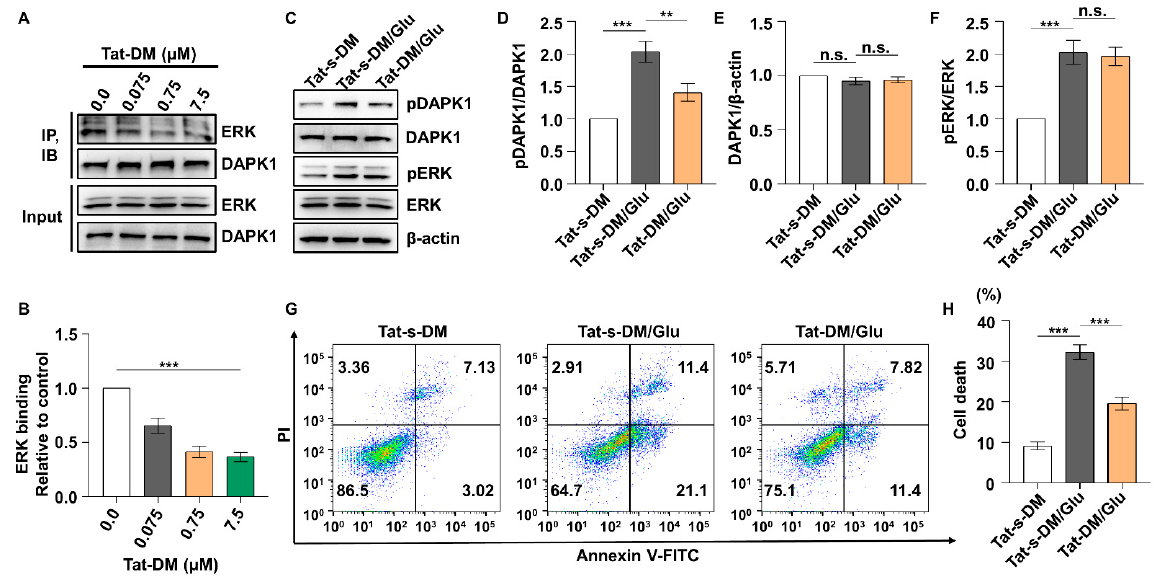
Figure 7. Uncoupling DAPK1 from ERK reverses neuronal apoptosis induced by glutamate. HT22 cells were incubated with 0, 0.075, 0.75, and 7.5 µ M Tat-DM for 180 min. ( A , B ) HT22 cell lysates were immunoprecipitated with DAPK1 antibody, resolved on SDS-PAGE gels and subjected to immunoblotting assays using anti-DAPK1 or anti-ERK antibodies (*** p < 0.001; one-way ANOVA with Tukey’s multiple comparisons test). HT22 cells were pretreated with 7.5 µ M Tat-DM for 180 min followed by washing with PBS. Cells were harvested 1 h after 10 mM glutamate incubation and used in immunoblotting assays with anti-pSer735-DAPK1, anti-DAPK1, anti-pThr202/Tyr204 ERK, anti-ERK, or anti- β -actin antibodies ( C – F ), and apoptosis was detected 24 h after glutamate treatment by flow cytometry ( G , H ) (** p < 0.01, *** p < 0.001; one-way ANOVA with Tukey’s multiple comparisons test). n.s., not significant ( p > 0.05). All data represent the mean ± SD of three independent experiments.